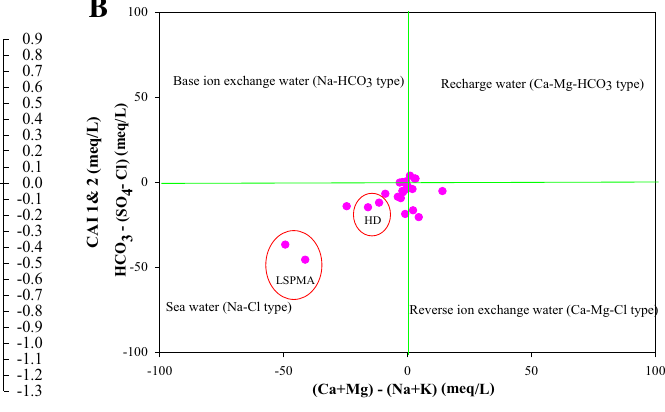
Fig. 3 a CAI 1 and CAI 2, b Chadha diagrams for hydrogeochemical facies